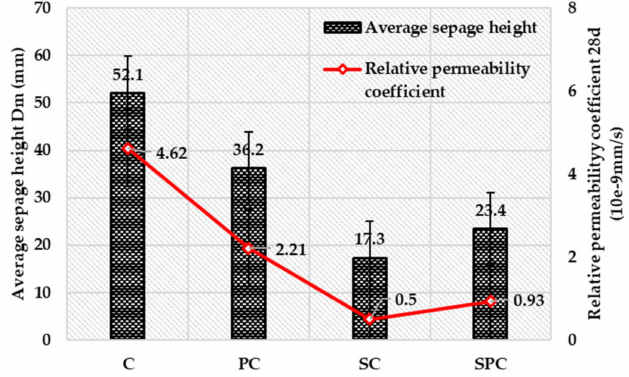
Figure 14. Impermeability test results of impermeable